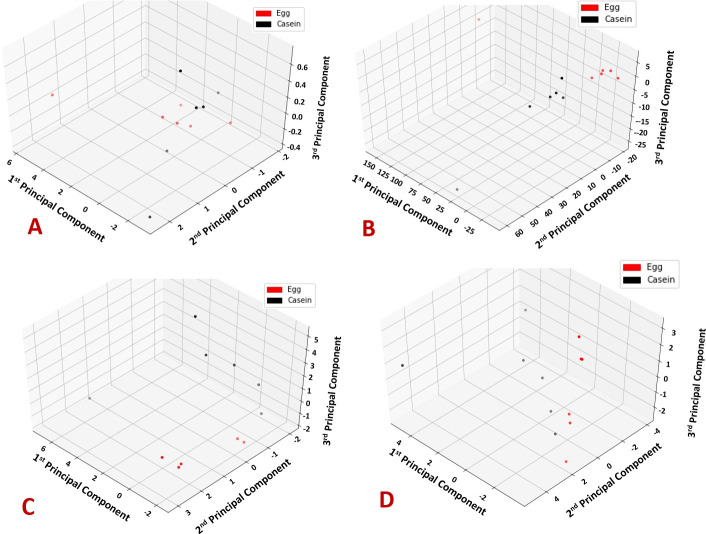
Principle component analysis.Samples in the first three principle component space are colored in red or black for either WE or CAS, respectively. Each panel displays PCA results using microRNA data or mRNA data are colored by dietary treatment groups with A) ZDF microRNA, B) ZDF mRNA, C) lean microRNA, D) lean mRNA.